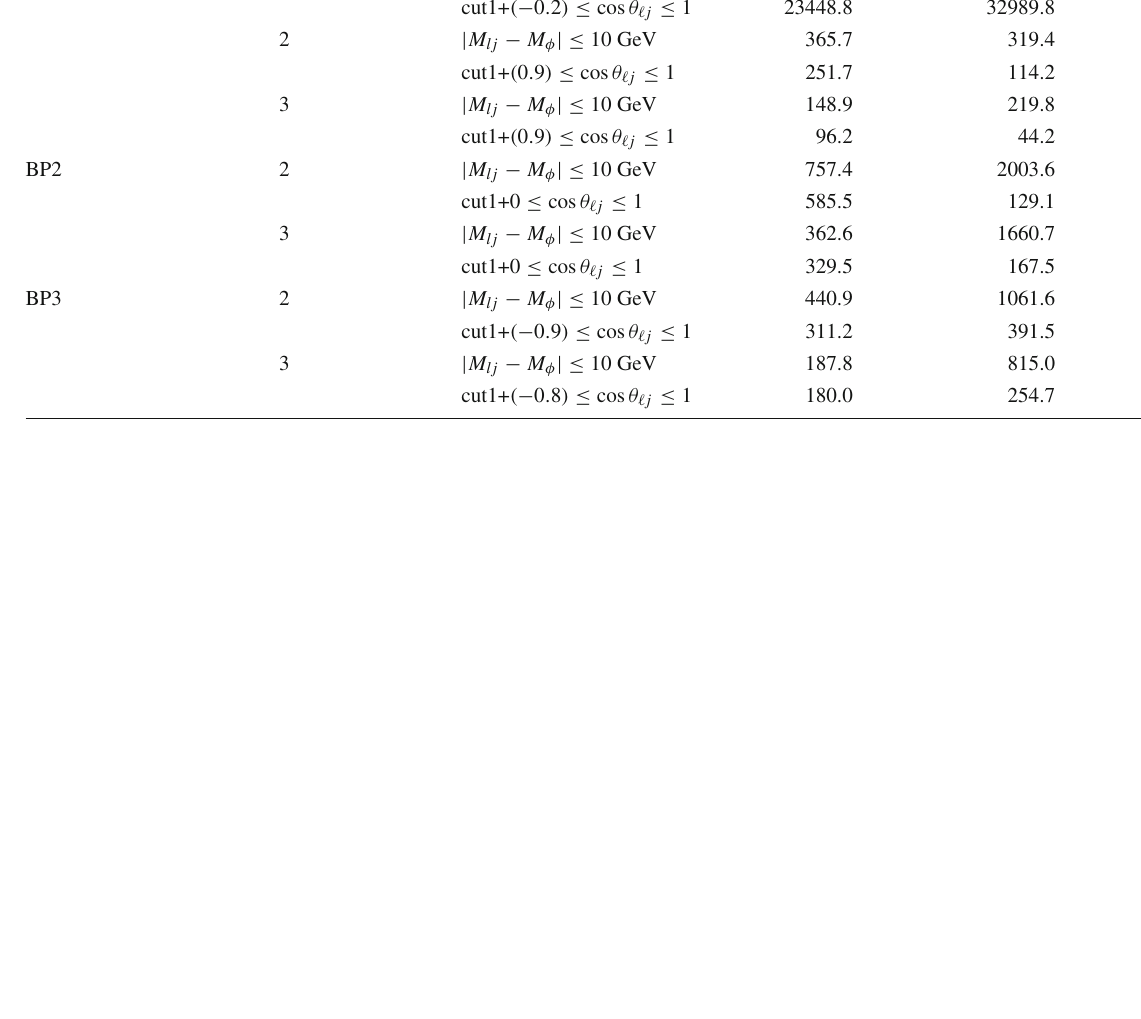
Table 8 Signal-background analysis for leptoquark ( R + 5 Bench-mark